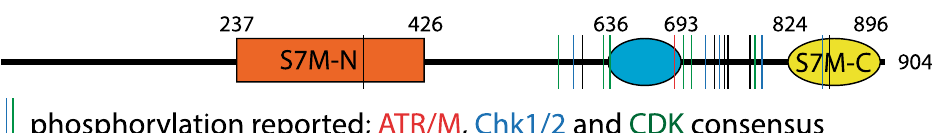
Figure 1. Domain architecture of human MTBP with reported phosphorylation sites. Schematic of the MTBP protein. Reportedly phosphorylated consensus sites for ATR/M (S/T-Q, red, T687), Chk1/2 (R/K-x-x-S/T, blue, T577, S738, S755, T804, S846) and CDK (S/T-P, green, S539, T635, S639, S703, S707, T799) are indicated by vertical lines (see main text for references). S7M-N, -C, Sld7-MTBP amino and carboxy-terminal domains; blue oval, metazoa-specific domain; aa, amino acids; numbers, aa positions in human